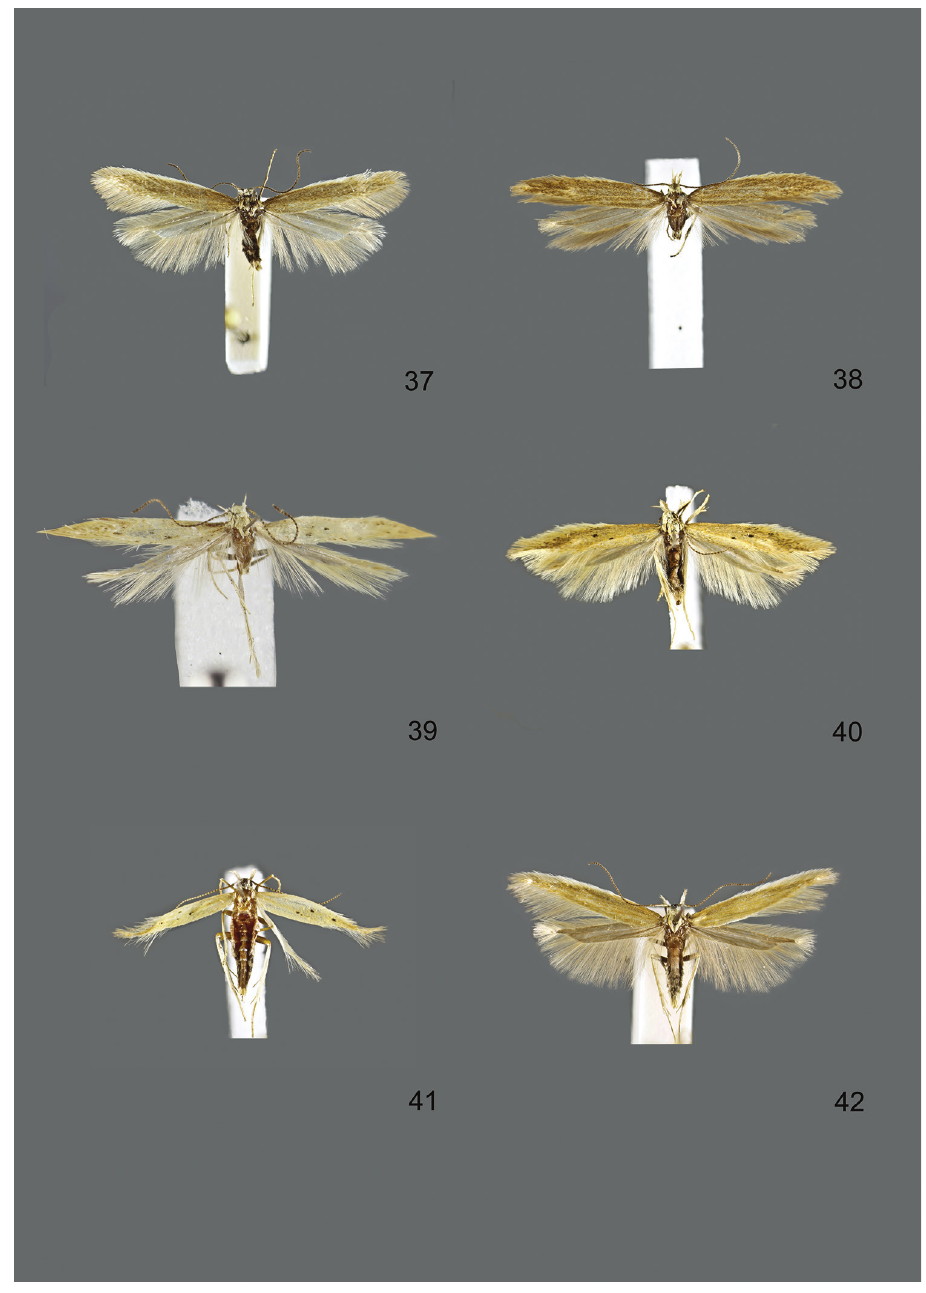
Figures 37–42. Megacraspedus adults in dorsal view. 37 M. dolosellus (Zeller, 1839) – male (form in- certellus ), Bulgaria (RCZT) 38 M. dolosellus (Zeller, 1839) – male, Greece (ZMUC) 39 M. neli sp. n. – Holotype, male, France (TLMF) 40 M. faunierensis sp. n. – Paratype, male, Italy (TLMF) 41 M. fau- nierensis sp. n. – Paratype, female, Italy (TLMF) 42 M. gredosensis sp. n. – Paratype, male, Spain